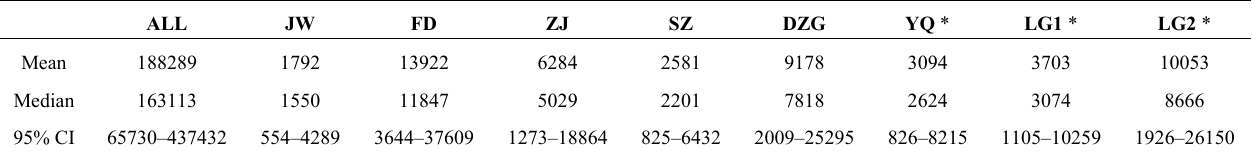
Table 1. Summary of the current Ne of K. obovata off Southeastern China estimated by the neutral loci of a criterion of 95% CI.